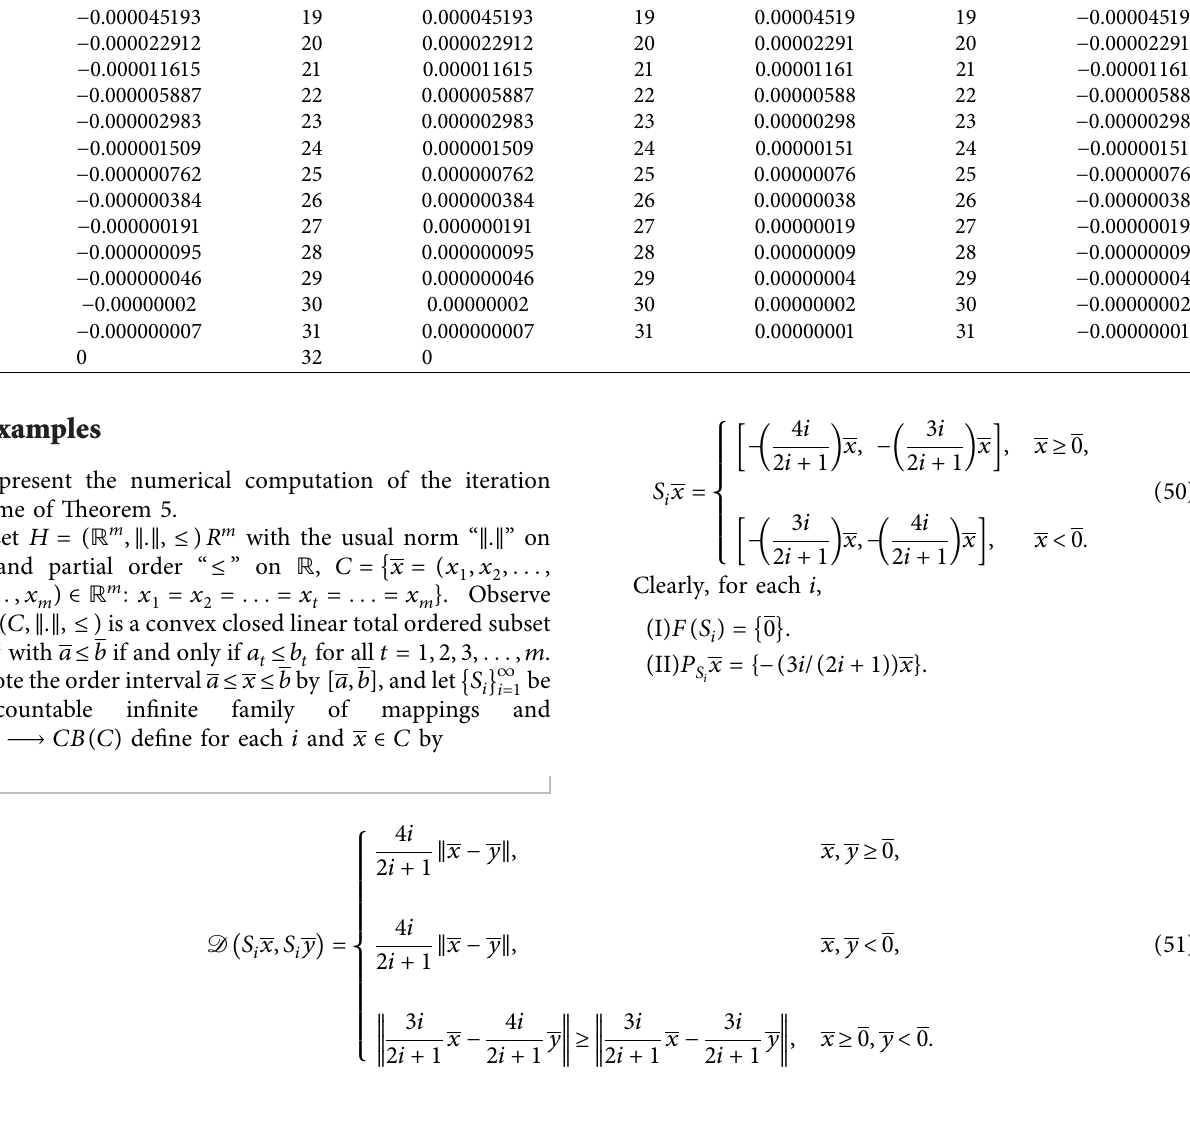
Table 1: Sequencesof coordinates x